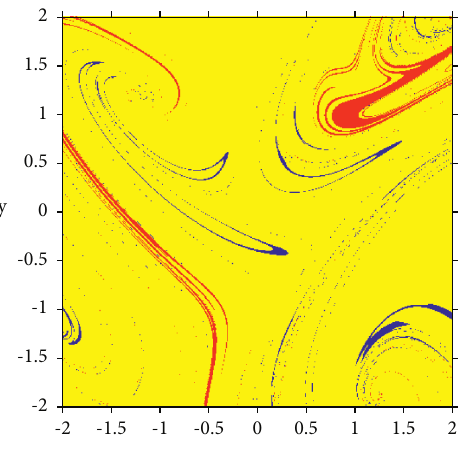
Figure 16: Basin of attraction of system (4) when [ q the initial condition of the third state variable z � 0.